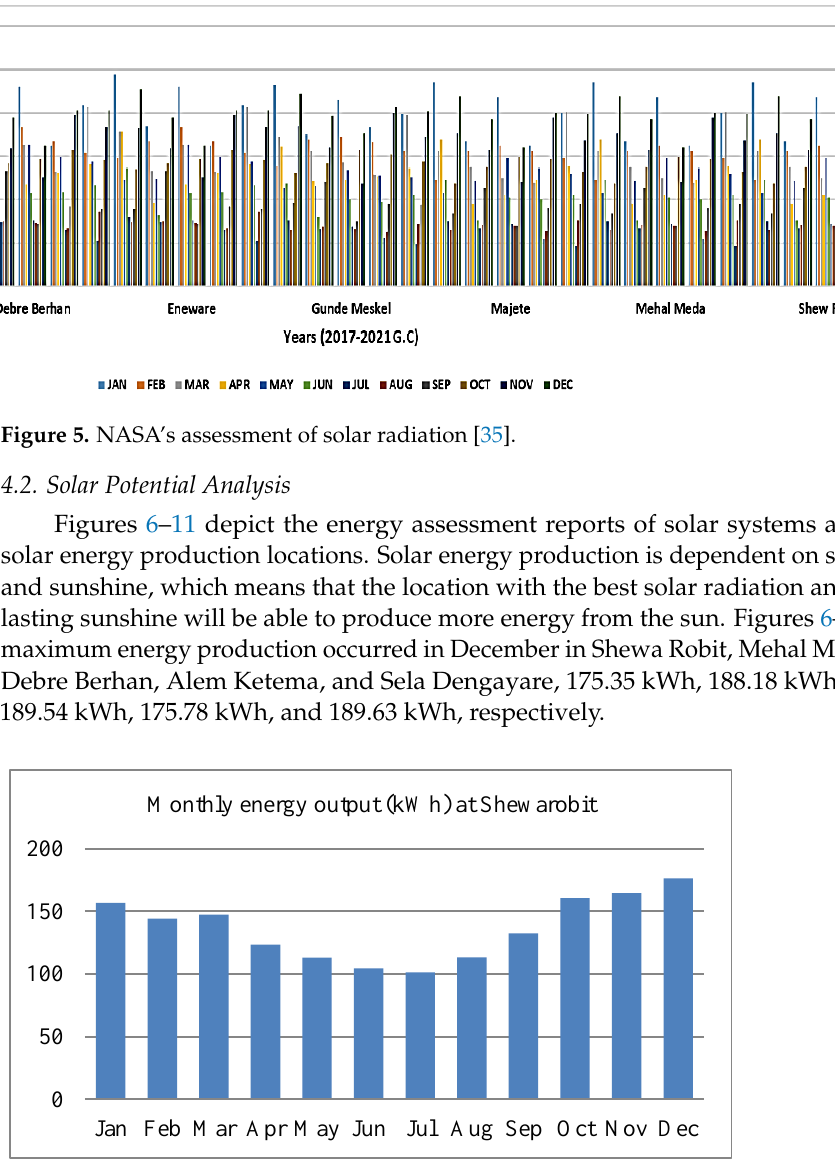
Figure 7. Energy assessment of solar system at Mehal Meda.